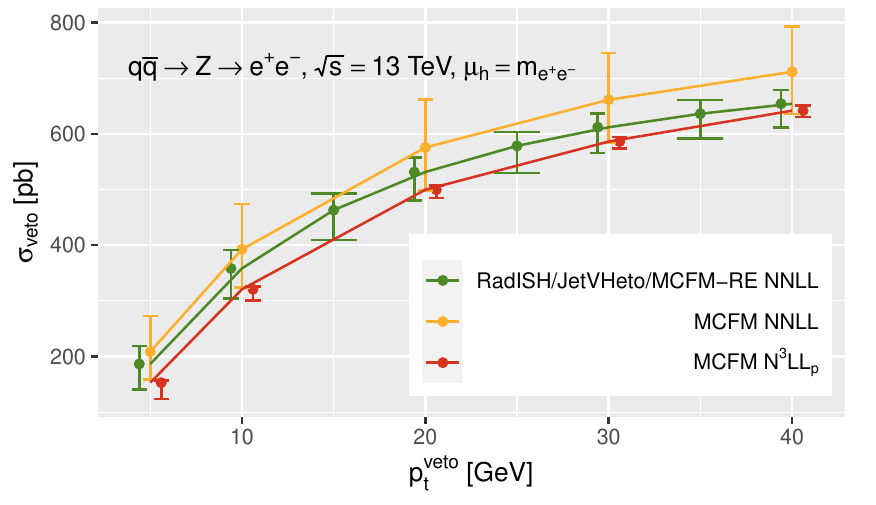
Figure 7 . Comparison of JetVHeto NNLL resummation with our NNLL and N 3 LL p results for Z production with cuts as in table 4.